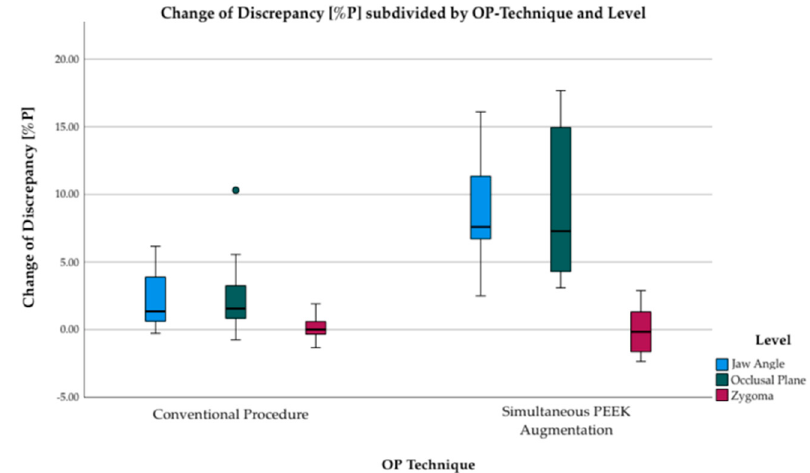
Figure 14. Boxplots displaying change of discrepancy in percentage points subdivided into orthog- nathic surgery only (cumulative groups 1, 2, and 3) and orthognathic surgery with additional PEEK bone augmentation (cumulative groups 4 and 5). Positive values are improvements in symmetry, while negative values mean a deterioration in symmetry. Improvements occur at the levels of jaw angle (blue) and occlusal plane (green) with mean 2.4 percentage points in orthognathic surgery only and mean 8.9 percentage points in orthognathic surgery with additional PEEK bone augmentation. However, there are no changes in the discrepancy at the level of zygoma (red) in any of the groups.